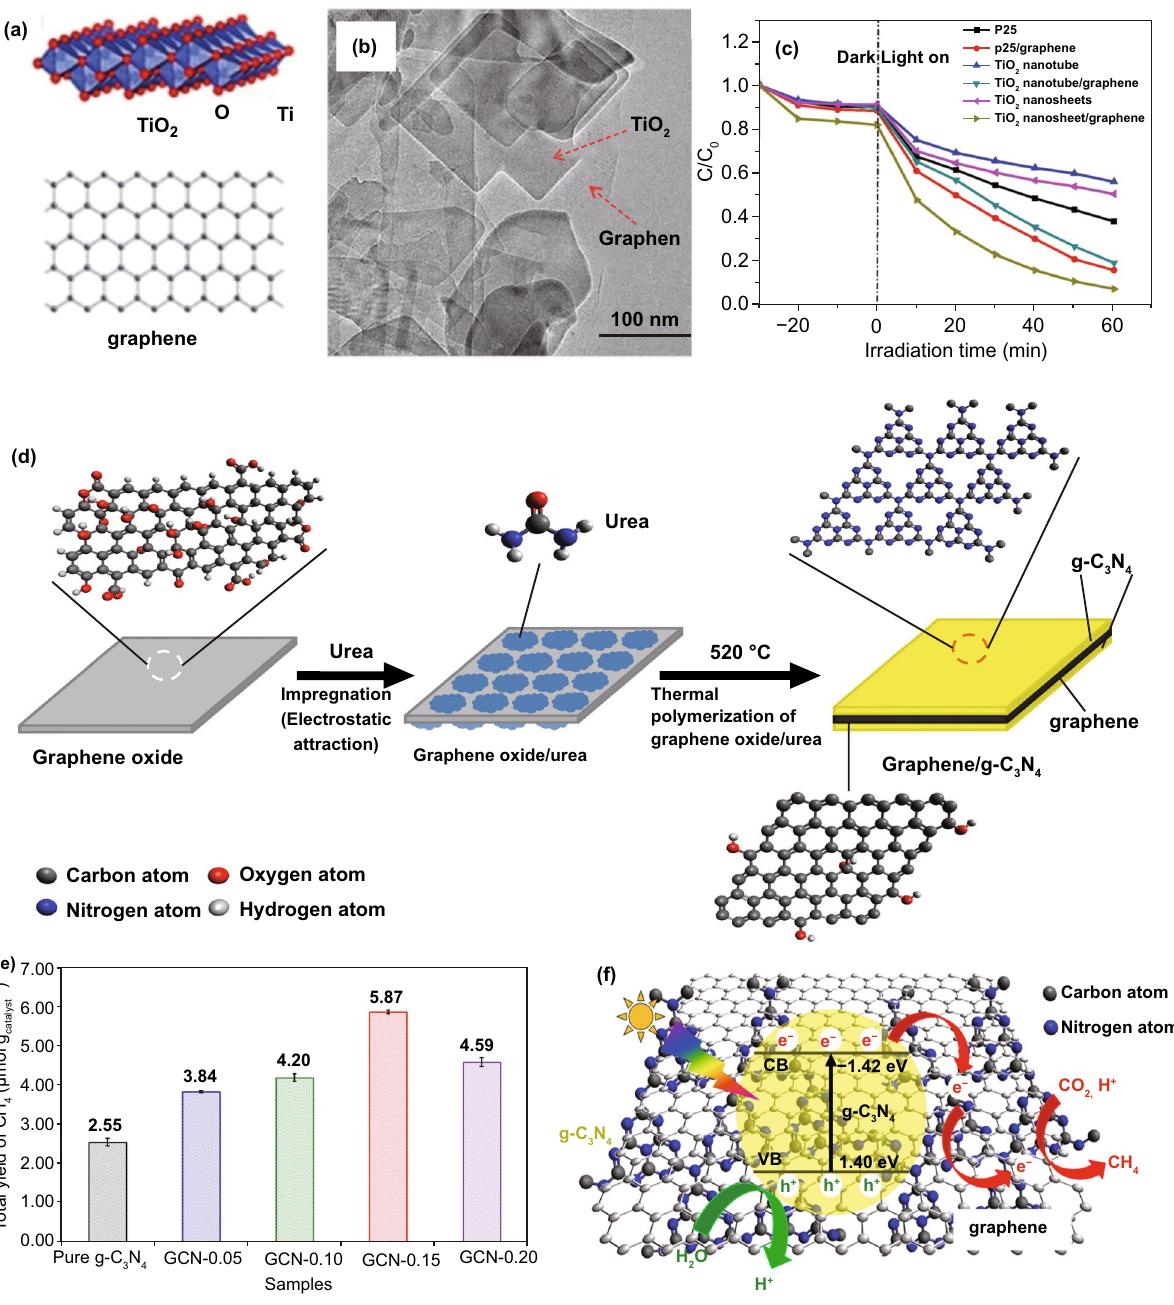
Fig. 28 a TiO 2 and graphene NS structures. b TEM and element mapping of graphene/TiO 2 hetero‑structure. c Photo‑catalytic degradation of rhodamine B (RhB) over different photo‑catalysts under irradiation of UV light. Adapted with permission from Ref. [304]. d Preparation of GCN samples through one‑pot impregnation–thermal reduction approach. e Total CH 4 yield over as‑synthesized photo‑catalysts. f Photo‑gener‑ ated charge transfer in GCN system for CO 2 reduction with H 2 O to make CH 4 . Adapted with permission from Ref.